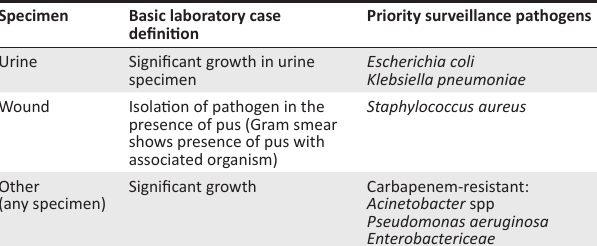
TABLE 1: Priority surveillance pathogens by specimen for inclusion in Ethiopia AMR surveillance.